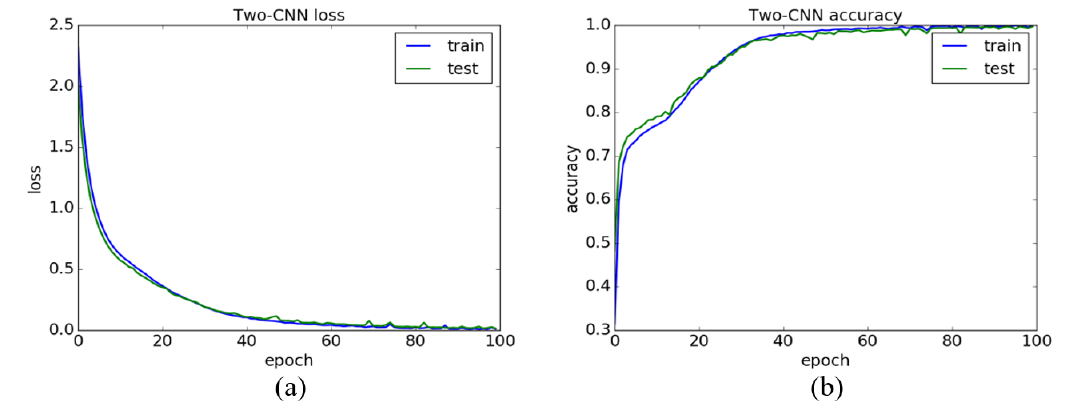
Figure 7. ( a ) Loss curve of the Dual-CNN; ( b ) accuracy curve of the